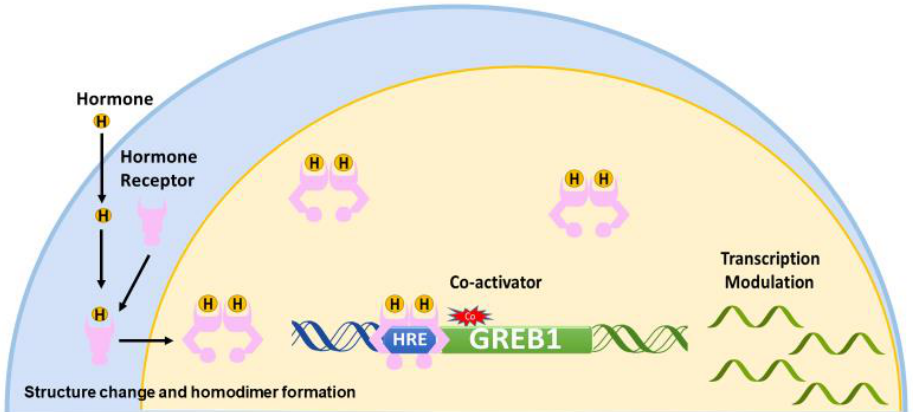
Figure 1. Model of the classic hormone-signaling pathway. The hormone enters the cell andbinds to a hormone receptor (HR). The arrows represent steps involved in activation of HR by its hormone. The HR forms a homodimer, undergoes a structural change to expose the hormone response element (HRE) binding domain, and enters the nucleus. Then, in conjunction with coactivators, HR binds an HRE to modulate the transcription of downstream genes such as GREB1. The arrows represent steps involved in activation of HR by its hormone.